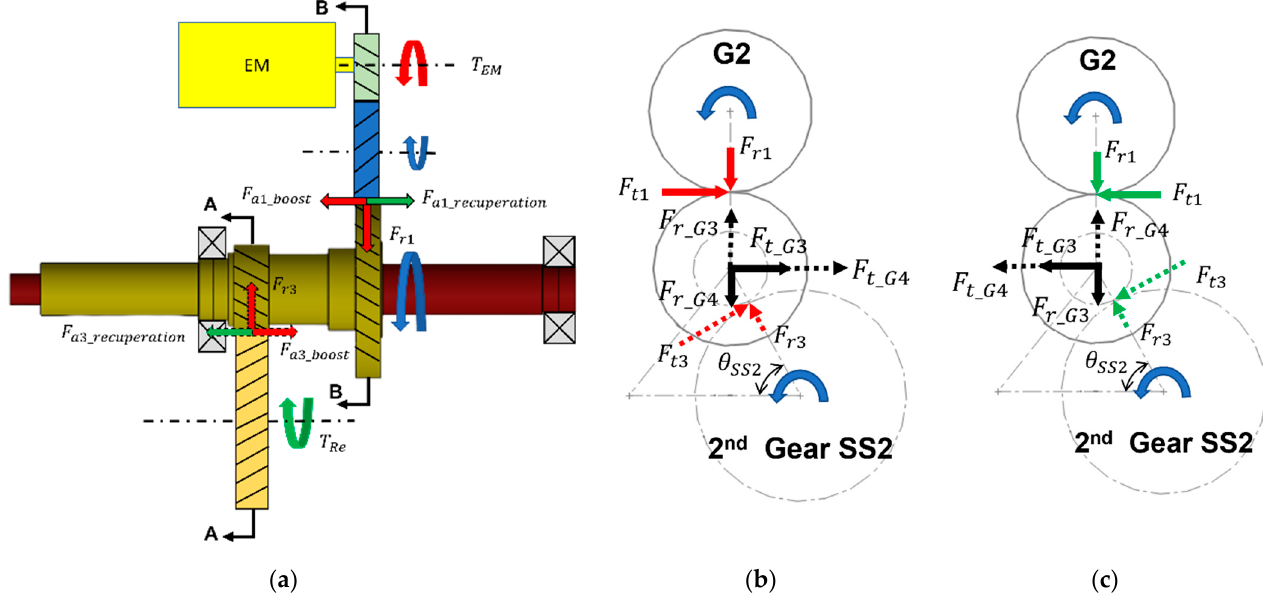
Figure 5. Second gear: ( a ) front view; ( b ) side view in boost mode; ( c ) side view in regeneration mode.